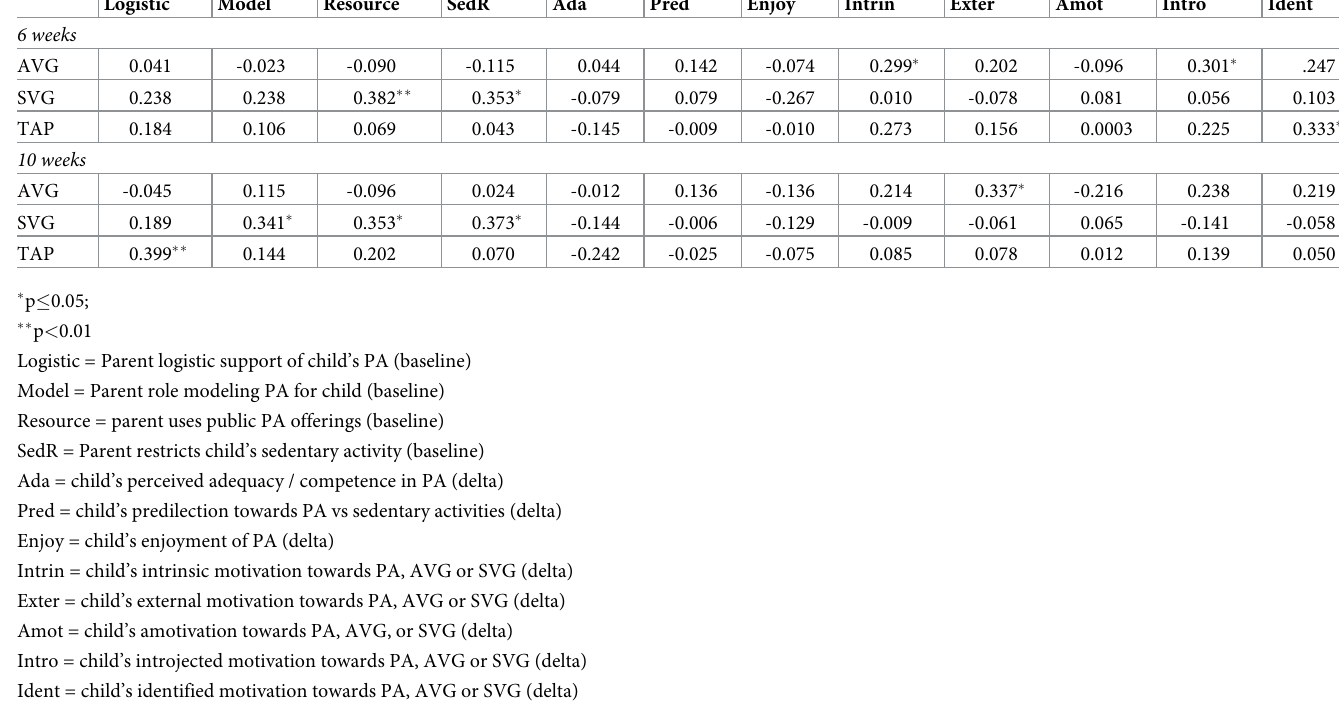
Table 5. Univariate correlations of AVG, SVG, and TAP recall delta scores with parent scores and child self-efficacy. Logistic